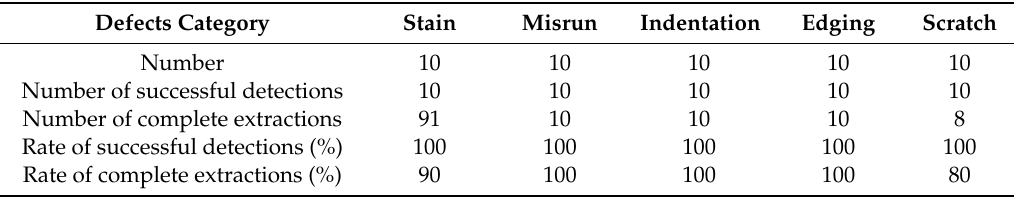
Table 3. The results for defect group.